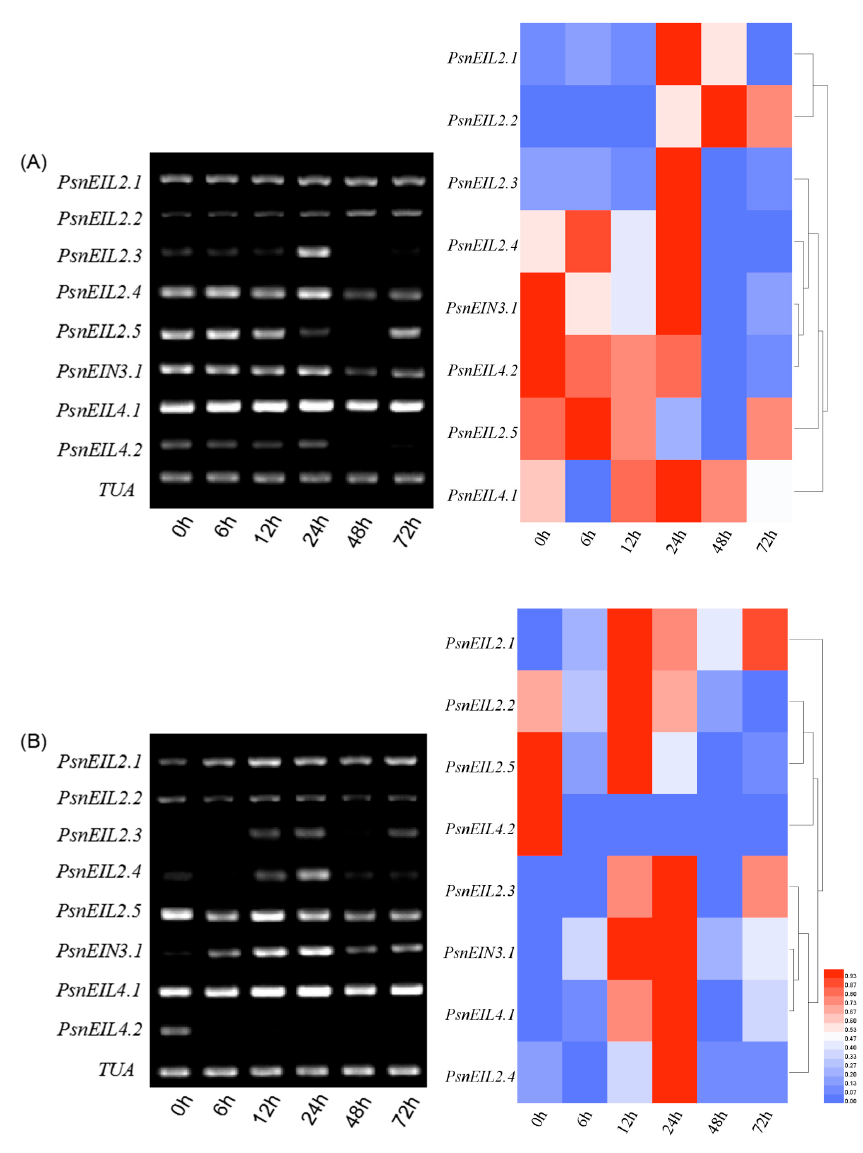
Figure 14. EIN3/EIL gene expression patterns of Populus × xiaohei under PEG stress. ( A ) Root. ( B ) Leaf.